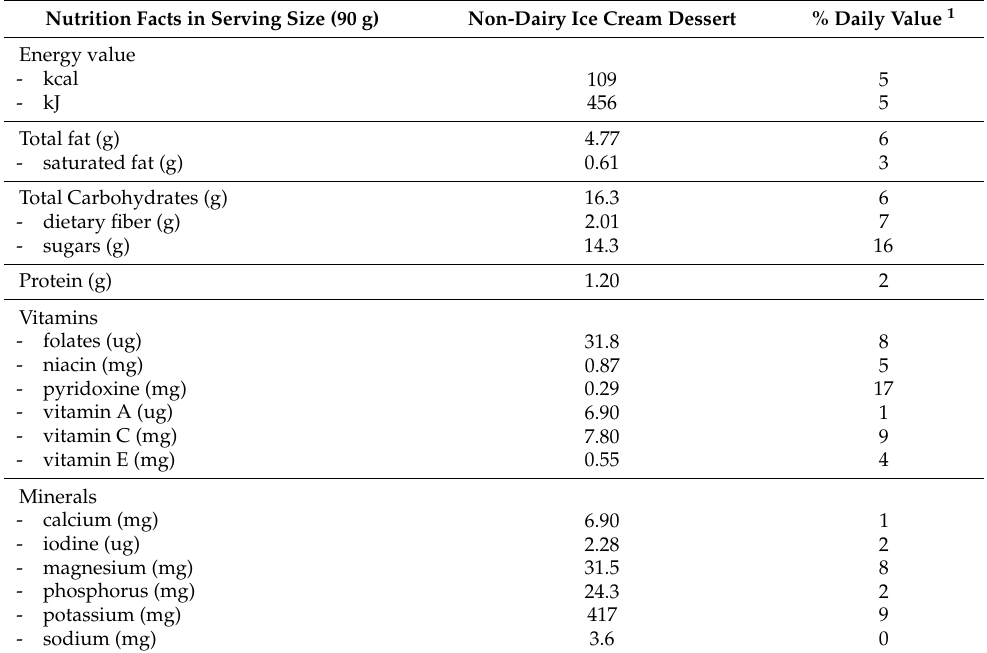
Table 2. Nutrition facts of a non-dairy ice cream dessert in one (90 g)